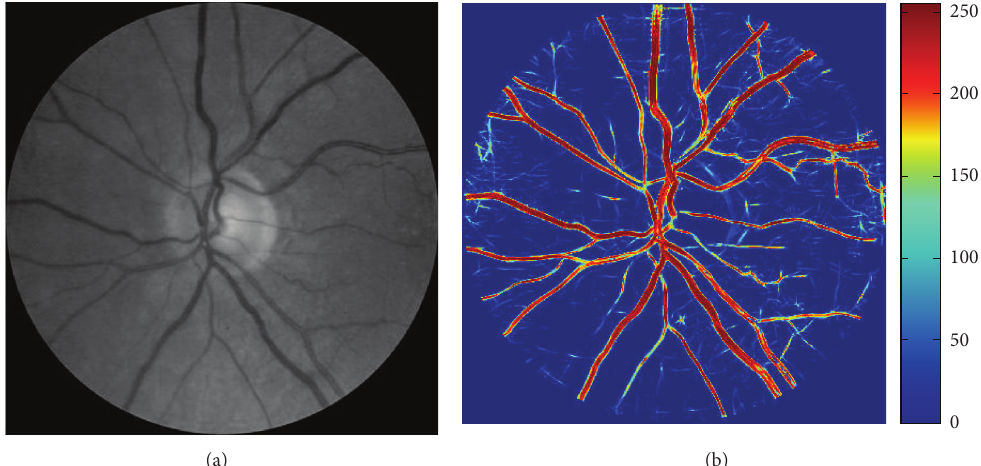
Figure 1: Retinal image enhancement. (a) Retinal image (green channel), (b) enhanced retinal image and color representation of the gray scale intensity values.